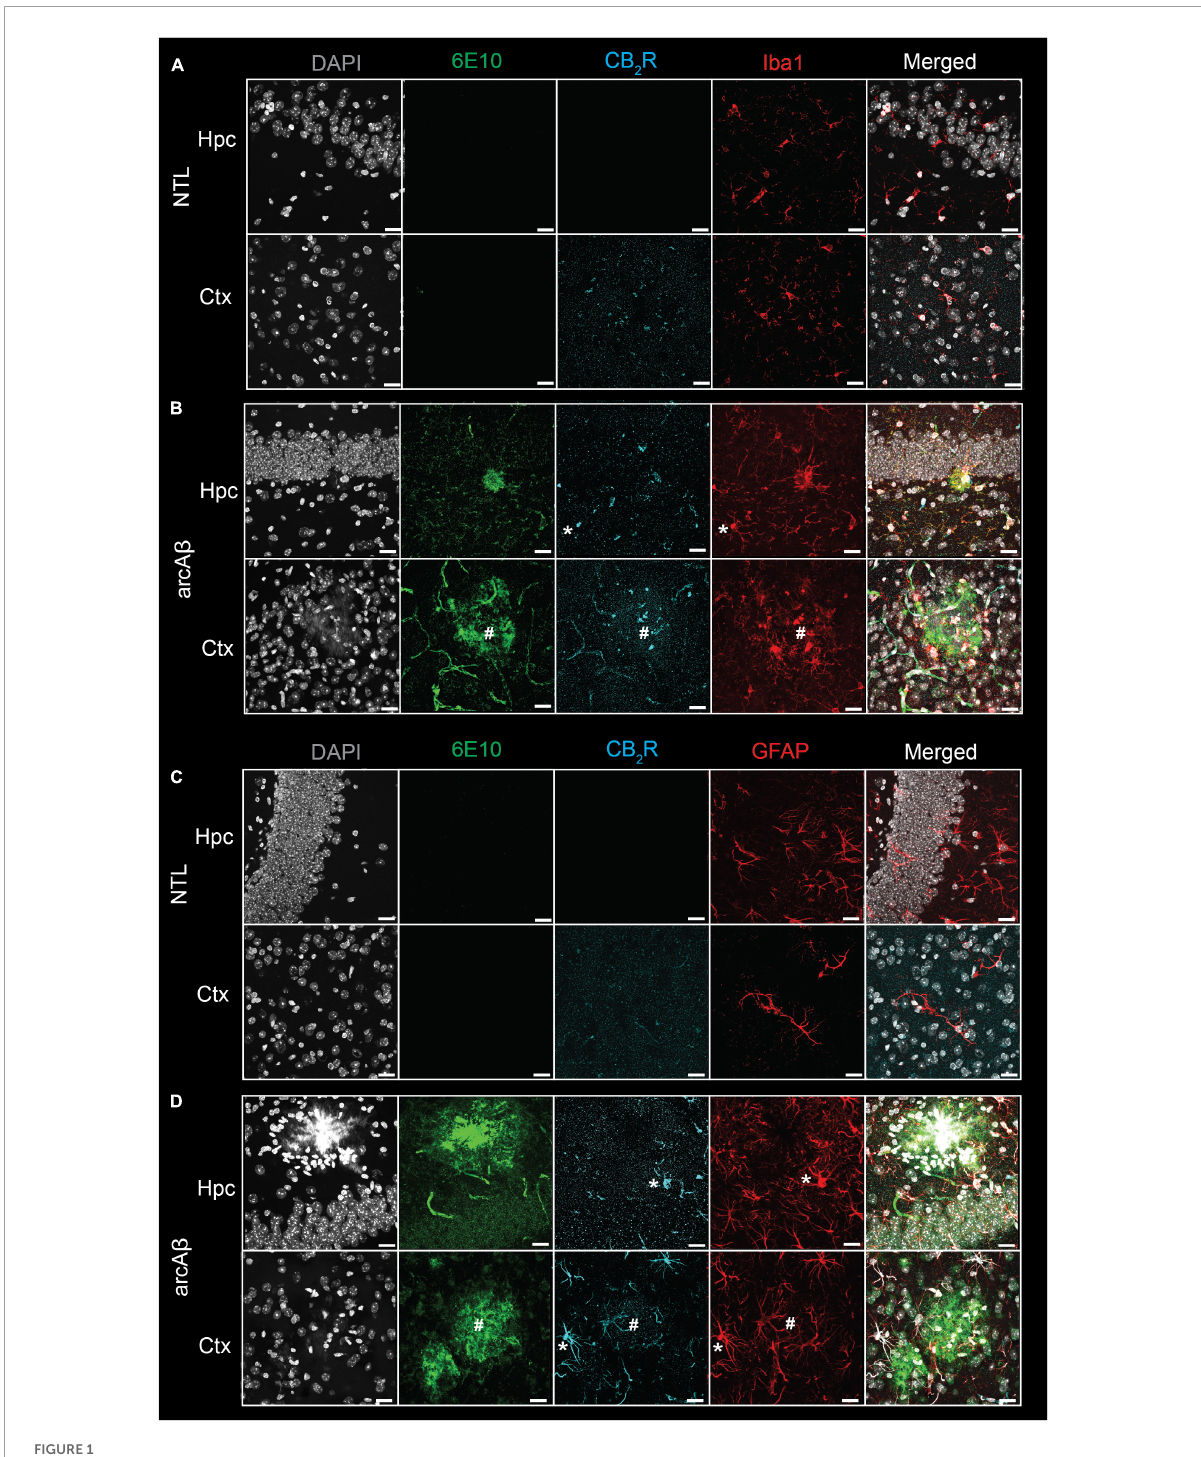
FIGURE1 Increased cannabinoid type 2 receptor (CB 2 R) in microglia and astrocytes associated with amyloid-beta deposits in 17-month-old arcA β mice. (A,B) Brain tissue sections of non-transgenic littermate (NTL, n = 3) and arcA β mice ( n = 3) were stained for A β (6E10 antibody, green), CB 2 R (cyan), and Iba1 (red) in the hippocampus (Hpc) and cortex (Ctx). Increased CB 2 R and Iba1 immunoreactivity inside and surrounding the plaque. (C,D) Staining for A β (6E10, green), CB 2 R (cyan), and GFAP (red) in the Hpc and Ctx. Nuclei were counterstained with DAPI (white). Increased CB 2 R and GFAP immunoreactivity inside and surrounding A β plaques. *Localization of CB 2 R on microglia or astrocytes outside plaque, # Colocalization of CB 2 R on microglia or astrocytes within plaque. Scale bar = 20 µ m. CB 2 R immunoreactivity was detected on both microglia and